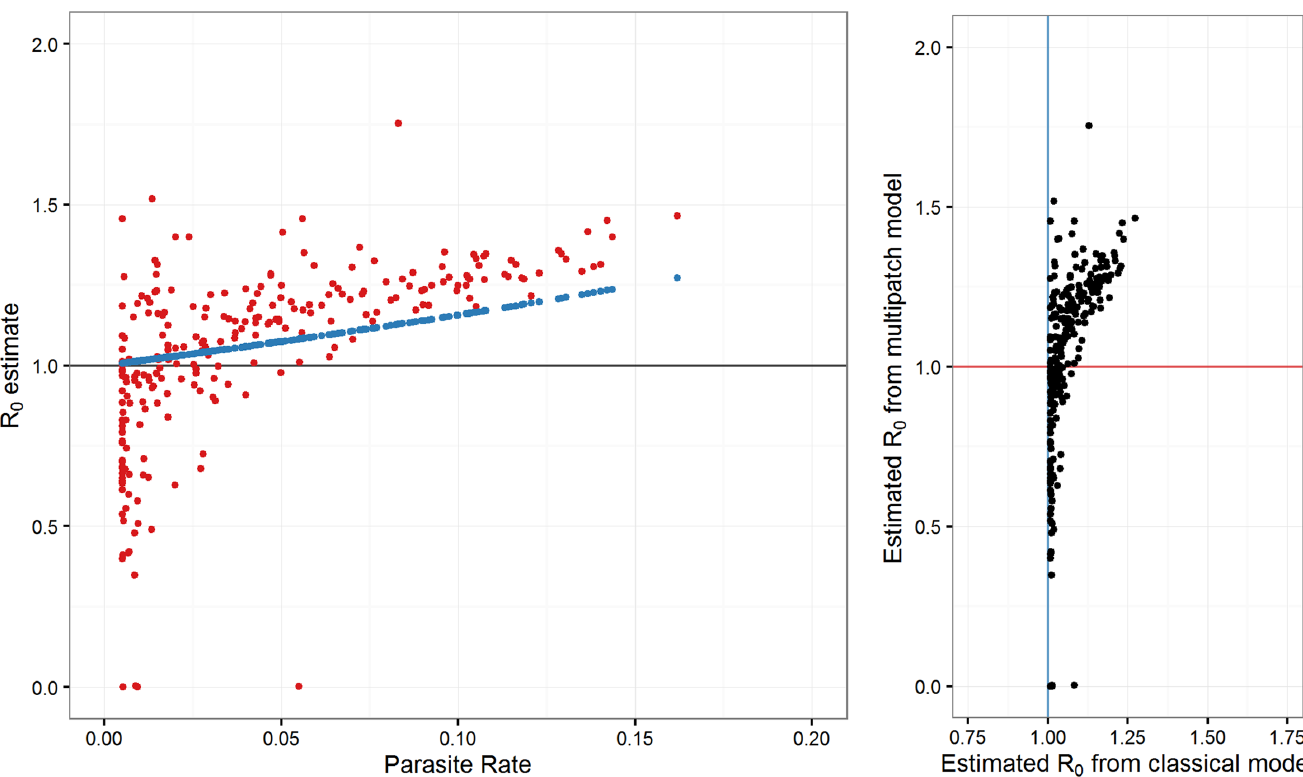
Fig 4. R 0 estimates using steady state analyses of multipatch model with mobility and classical model without mobility for all patches with nonzero PR. Left panel: R 0 estimates using both models compared with observed PR in each patch. Right panel: Relationship between R 0 estimates from both models.